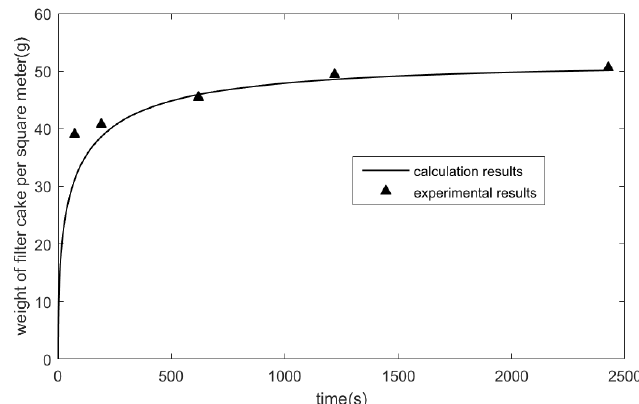
Figure 12. The predicted and experimental filter cake mass versus time.